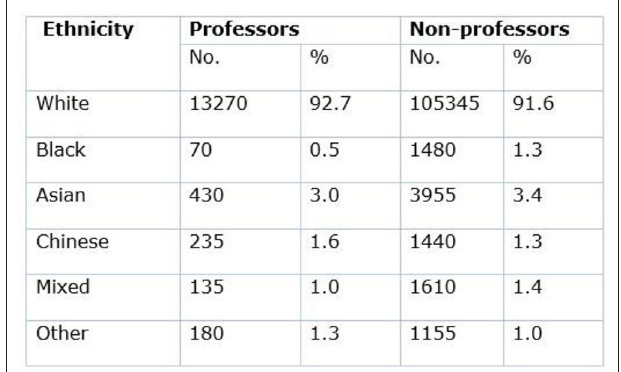
FIGURE 1 | UK academic staff by professorial category and ethnic group (Source: Unit, 2015).